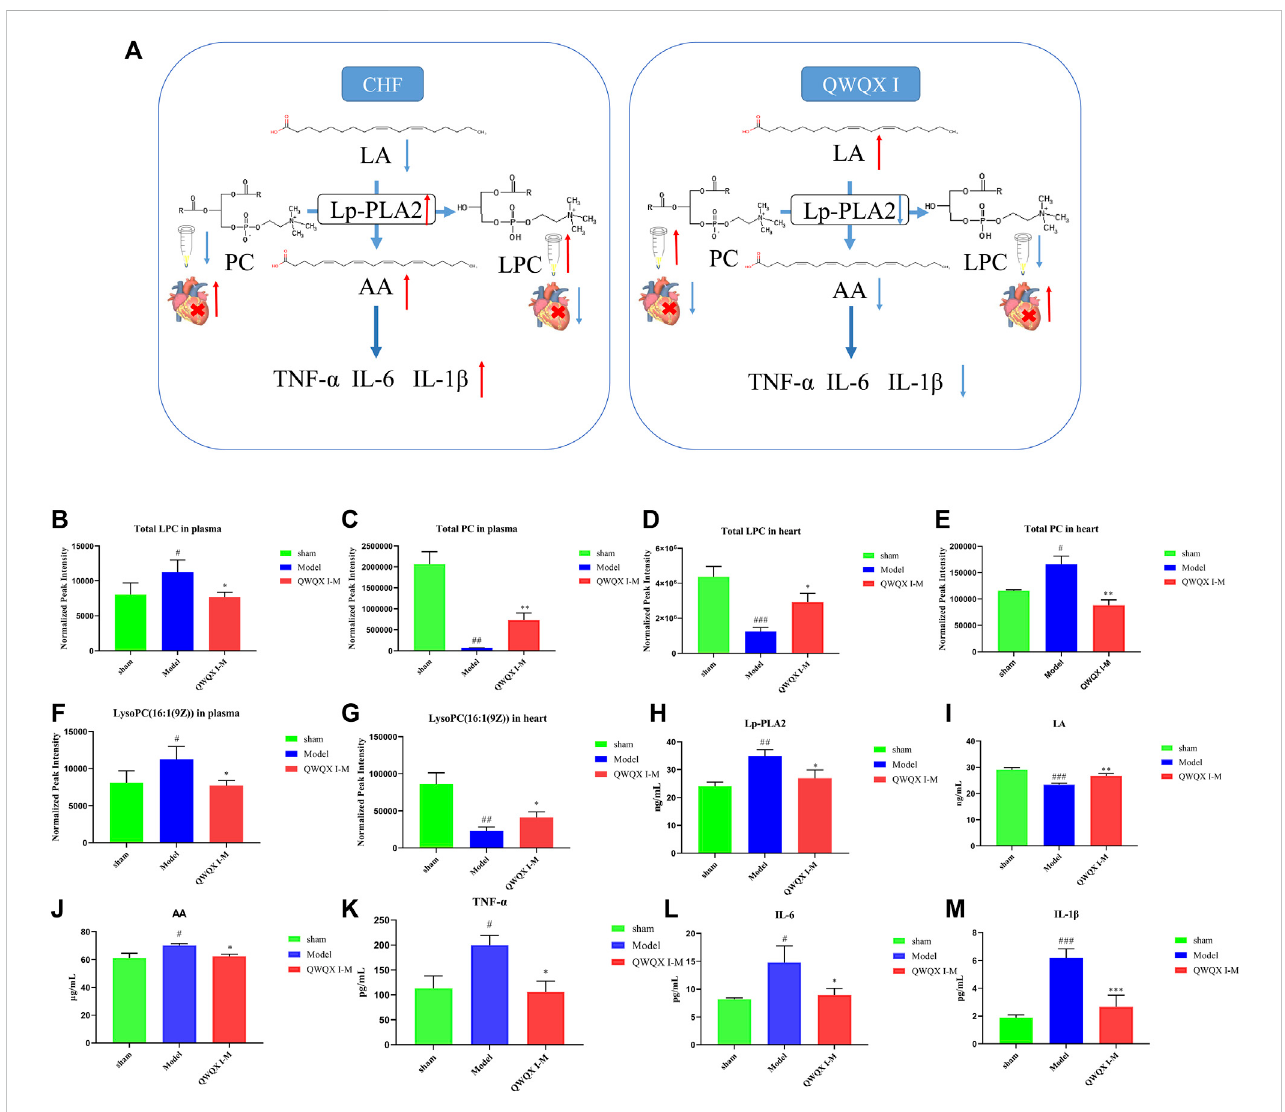
FIGURE 10 Screening ofplasmaand cardiactissue candidate keydifferential metabolites inCHF ratsaftertreatmentwith QWQX I. (A) Potential metabolic pathways. (B) Total LPC inplasma. (C) Total PCinplasma. (D) TotalLPC inhearttissue. (E) Total PCinheart tissue. (F) LysoPC(16:1(9Z))inplasma. (G) LysoPC(16:1(9Z))in heart tissue. (H) The level of Lp-PLA2. (I) The level of AA. (J) The level of LA. (K) The level of TNF- α . (L) The level of IL-6. (M) The level of IL-1 β . Data are expressedastheMean±SEM. # p < 0.05, ## p < 0.01, ### p < 0.001,theModelgroupvs.theshamgroup;* p < 0.05,** p < 0.01,*** p < 0.001,drugtreatment group vs. the Model